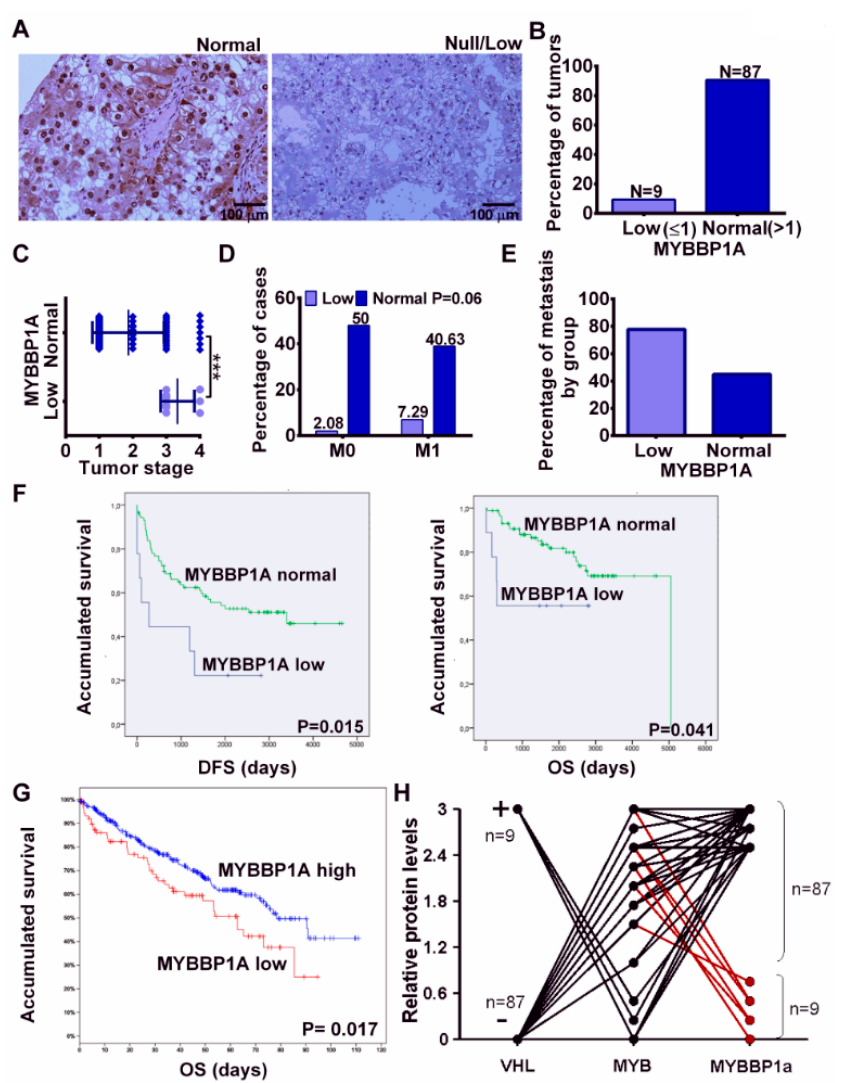
Figure 6. Loss of MYBBP1A in human renal tumors. ( A ) Representative images of renal tumors with normal levels of MYBBP1A (left) and null/low levels of MYBBP1A (right). Scale bar: 100 µM ( B ) Percentage of renal tumors expressing low or normal levels of MYBBP1A . ( C ) Correlation of tumor stage with MYBBP1A expression levels. *** p > 0.001 ( D ) Percentage of cases with metastasis (M1) and without metastasis (M0) in patients with tumors with low and normal levels of MYBBP1A . Statistical analysis: Chi-square ( E ) Percentage of relative metastasis in low levels and normal levels of MYBBP1A groups. ( F ) Kaplan-Meier curves indicate that patients with tumors with low MYBBP1A showed worse disease-free survival and overall survival than patients with tumors with normal levels of MYBBP1A . ( G ) Kaplan-Meier curve shows that patients with clear cell renal cell carcinomas (ccRCC) tumors with low MYBBP1A showed worse overall survival than patients with tumors with high levels of MYBBP1A . Data from TCGA. ( H ) Correlation of c-MYB, MYBBP1A and pVHL expression in renal tumors.